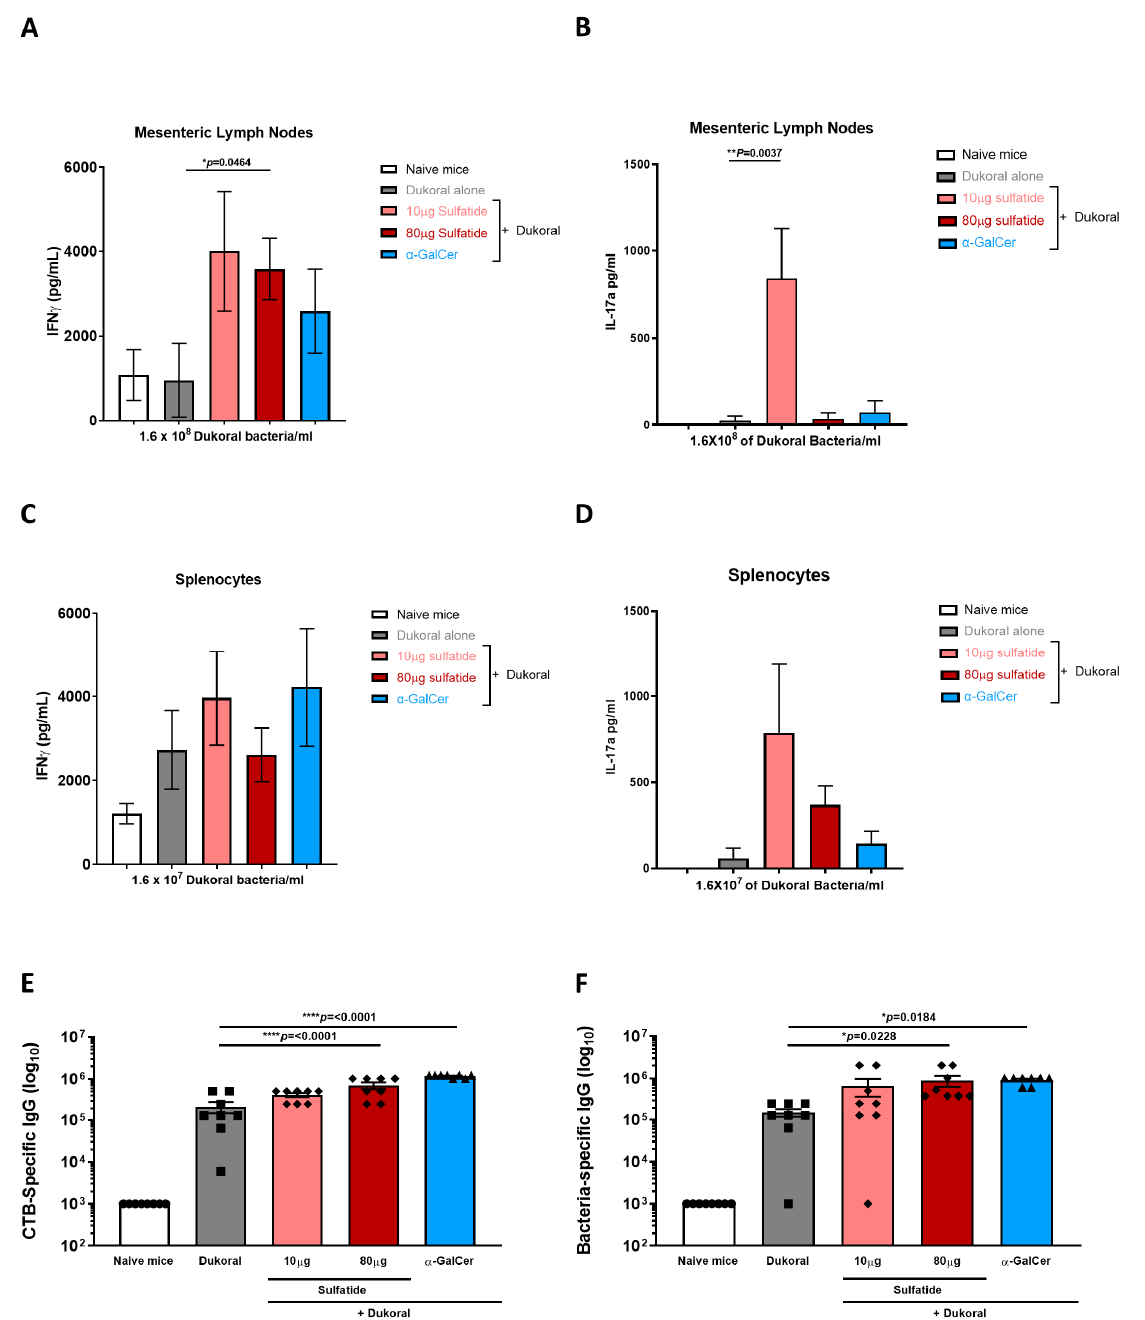
Figure 3. Oral co-administration of Dukoral ® with sulfatide enhances local and systemic IFN γ and IL-17A responses and antigen-specific serum IgG responses. Female C57BL/6 mice were immunised orally with Dukoral ® co-administered with 10 or 80 µ g sulfatide or 10 µ g α -GalCer or with Dukoral ® alone or with PBS (naïve mice). On day 43, spleens, MLNs and blood were collected. MLN cells ( A , B ) and splenocytes ( C , D ) were restimulated with 1.6 × 10 8 and 1.6 × 10 7 Dukoral ® bacteria/mL, respectively, for 72 h before measuring IFN γ ( A , C ) and IL-17A ( B , D ) in the supernatant by ELISA. Endpoint titres of CTB-specific IgG ( E ) and bacterium-specific IgG ( F ) were determined in serum by ELISA. Results presented are mean concentrations (pg/mL) or titres ± SEM. Significant differences between the group vaccinated with Dukoral ® alone or Dukoral ® and sulfatide are shown. Symbols show the groups of mice. Circles: naïve mice. Squares: mice immunised with Dukoral ® alone. Rhombus: mice immunised with Dukoral ® and sulfatide. Triangles: mice immunised with Dukoral ® and α -GalCer. Each symbol represents one animal in the